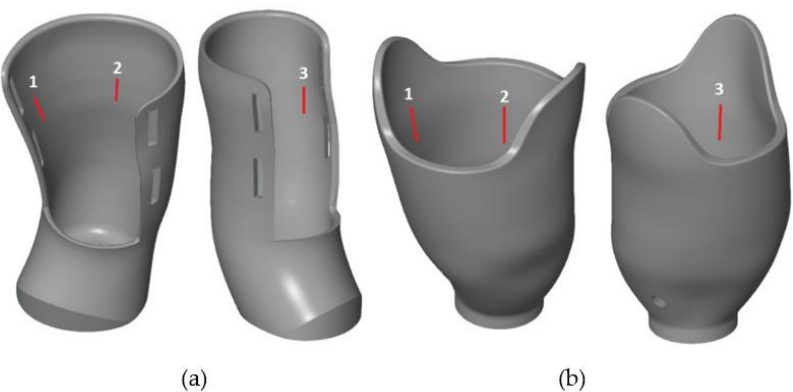
Figure 8. Places where the roughness measurement was carried out, socket type: ( a ) VEL and ( b )